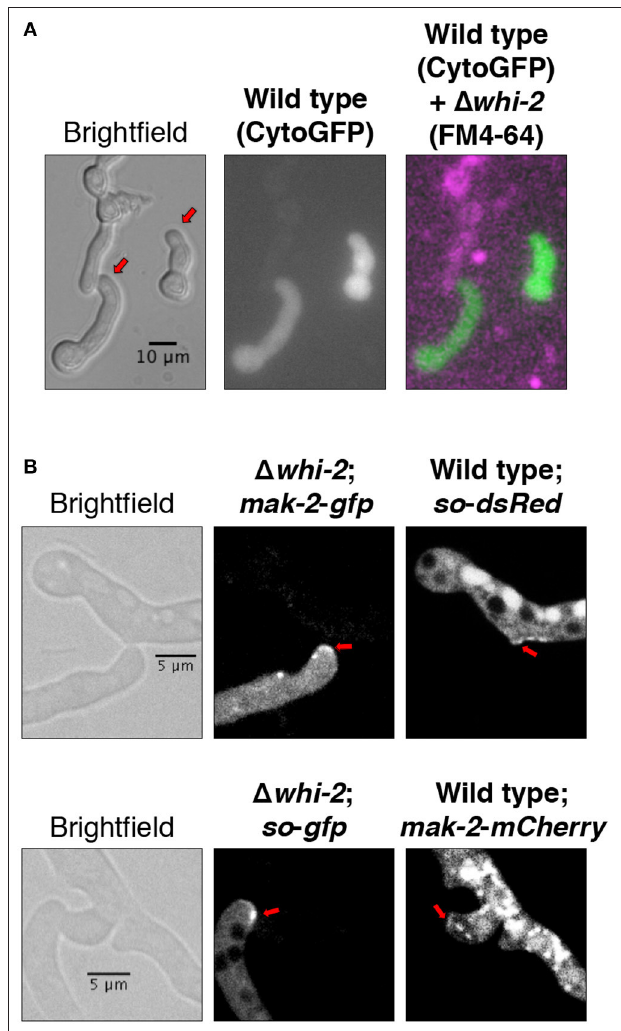
FIGURE 2 | Cells lacking whi-2 are capable of establishing chemotropic interactions with the wild type cells and show recruitment of MAK-2 and SO to CATs. (A) Cytoplasmic GFP-expressing wild type cells were mixed with FM4-64-stained 1 whi-2 cells and observed by microscopy after germination. (B) MAK-2-GFP-expressing (upper panel) or SO-GFP-expressing (lower panel) 1 whi-2 cells were mixed, respectively, with SO-dsRed-expressing or MAK-2-mCherry-expressing wild type cells and observed by microscopy after germination. Note the formation of CATs (red